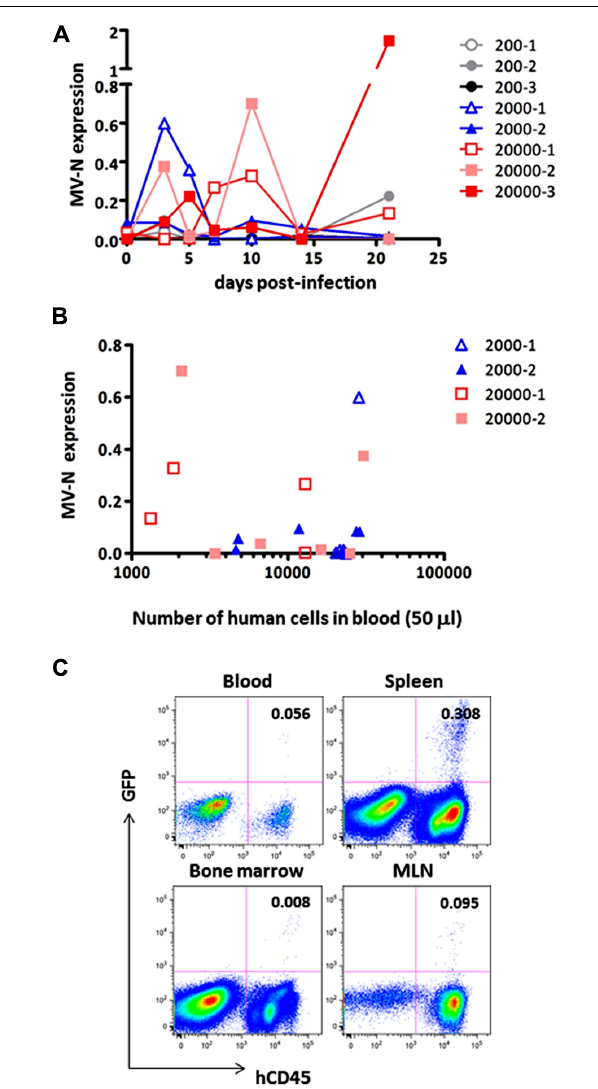
FIGURE 4 | Monitoring of MV replication in vivo .Two to three hNOJ mice per group were challenged with MV AIK-C-EGFP at 20,000 (squares), 2,000 (triangles), or 200 pfu (circles).The PBMCs of these mice were collected at day 3, 5, 7, 10, 14, and 21 p.i. (A) The level of MV-N expression in the blood of infected hNOJ.Vertical axis shows the level of MV-N relative to that of RNaseP, as described in the legend for Figure 2B . (B) For some mice (depicted using the same symbol as (A) ), the number of human cells per 50 μ l of blood used for RNA extraction and analyzed for MV-N expression was plotted on the X-axis. (C) An hNOJ mouse infected with MV at a low dose (gray closed circle, 200-2) exhibited an increased level of MV-N. At day 21 p.i., the mouse was sacrificed; cells from blood, spleen, BM, and mesenteric lymph node (MLN) were prepared. Cells were stained and analyzed as described in the legend for Figure 2A